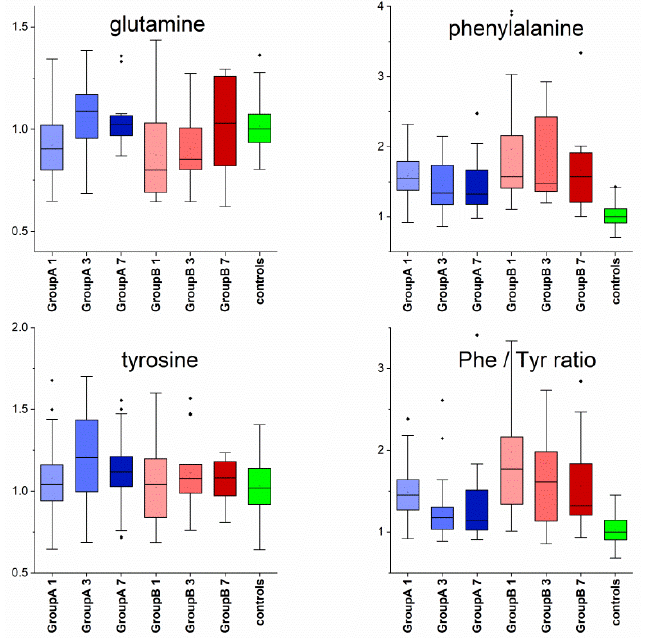
Figure 4. Relative concentrations of selected metabolites related to immunity in blood plasma for patient Groups A and B on Day 1, Day 3, and Day 7. Values are relativised to the median of controls given a value of 1.